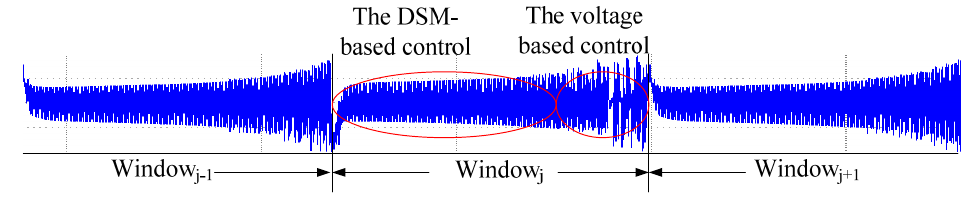
Figure 4. The summary information and its changing